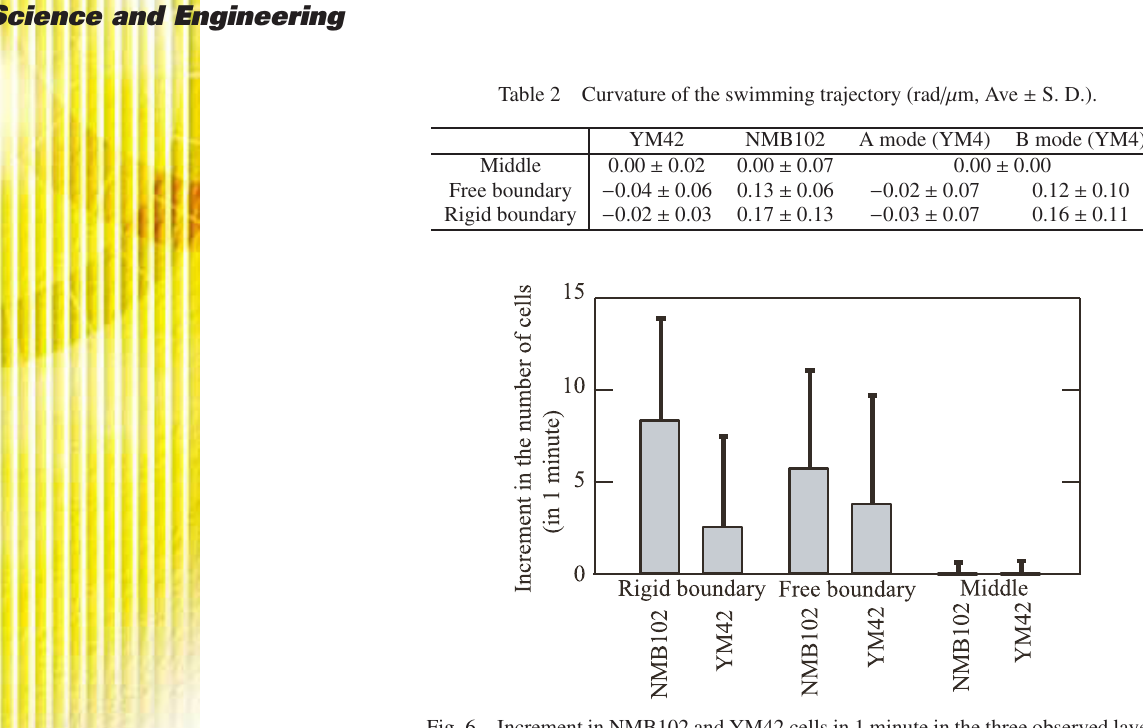
Fig. 6 Increment in NMB102 and YM42 cells in 1 minute in the three observed layers. Bars and thick lines indicate the average and standard deviation, respectively. to clarify the hydrodynamic aspects of these